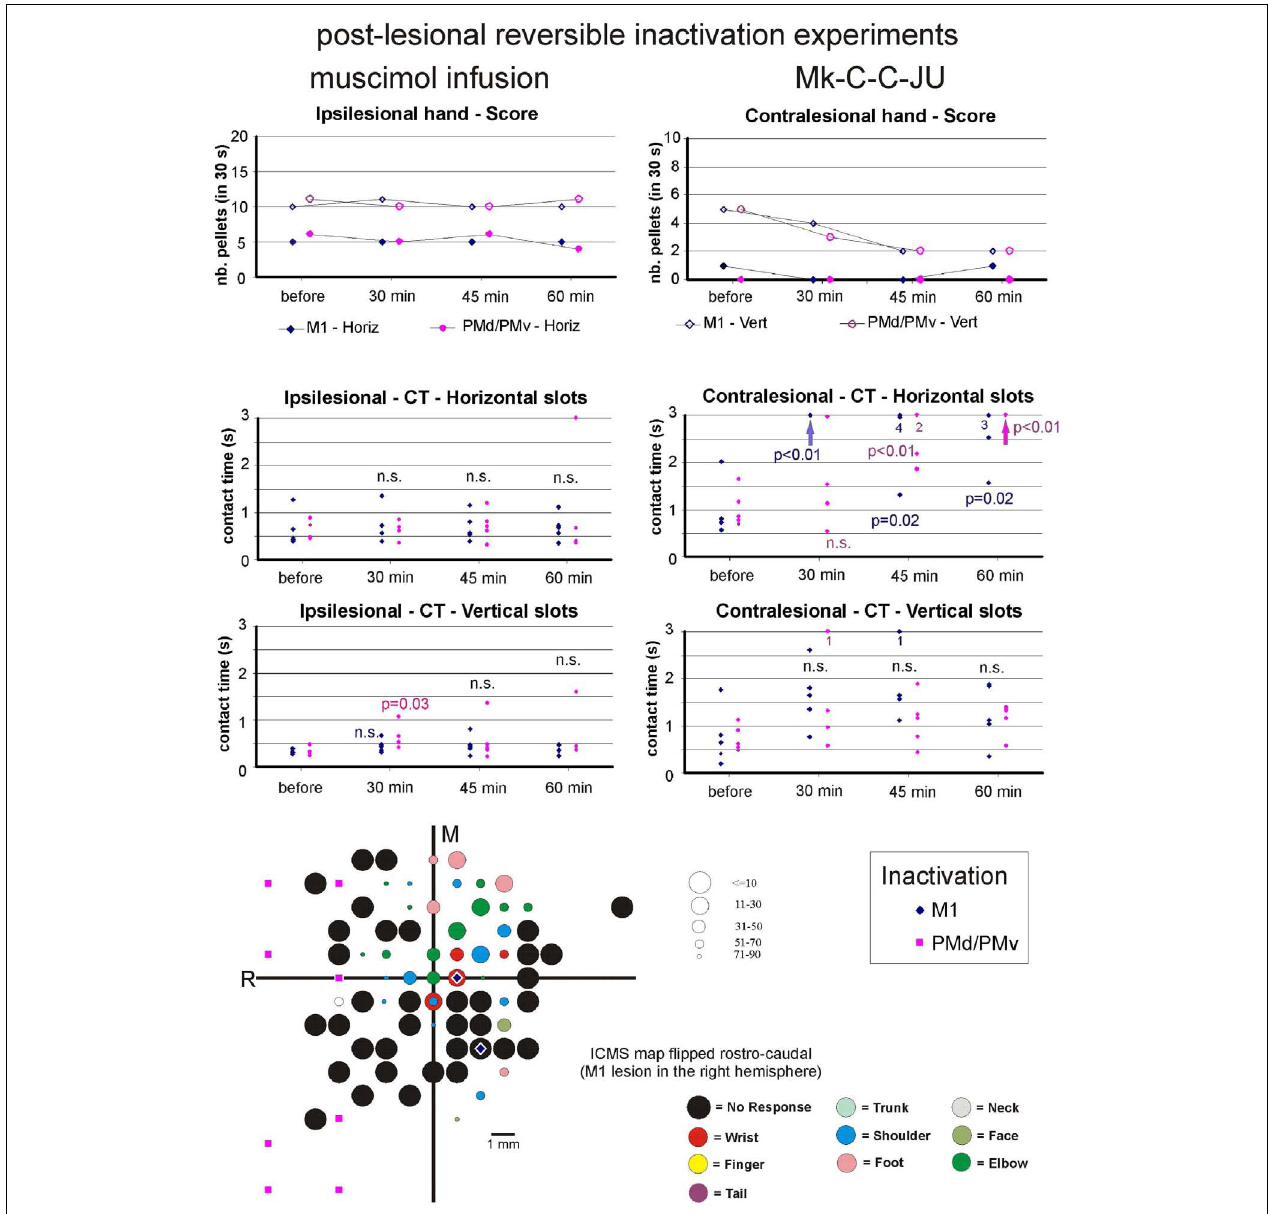
FIGURE 10 | Inactivation data and post-lesion ICMS data for Mk-C-C-JU (same conventions as in Figure 8)